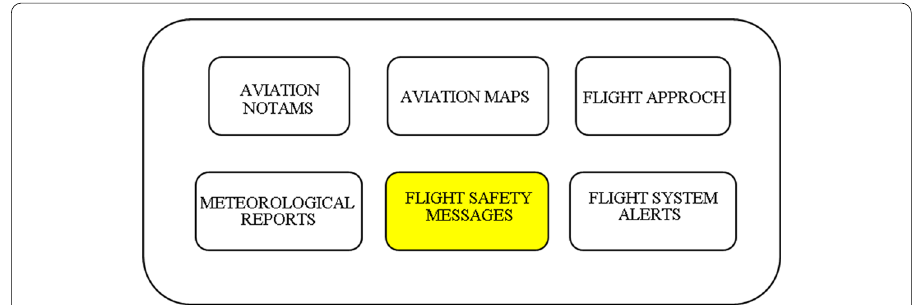
Fig. 1 Mass of aviation information required by pilots and flight attendants and scope of